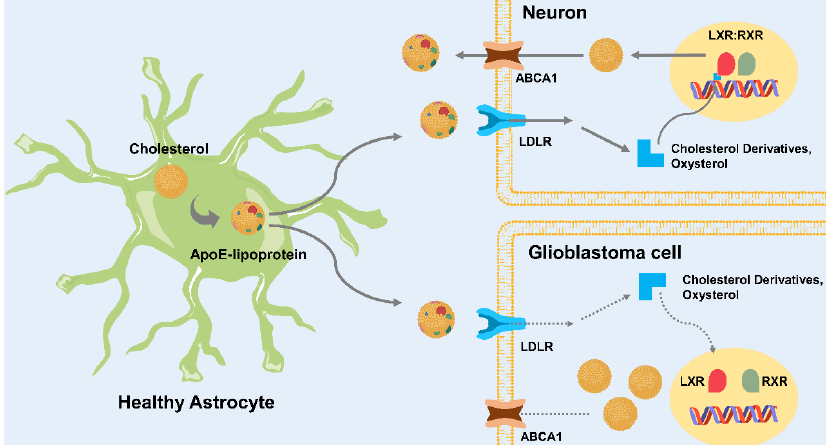
Figure 1. Neuron and GBM cells depend on astrocytes to synthesize cholesterol via de novo synthesis. Neurons and GBM cells do not use de novo synthesis of cholesterol. Instead, they uptake exogenous cholesterol in ApoE-lipoprotein from astrocytes. ApoE-lipoprotein interacts with LDL receptors. Then, oxysterol and cholesterol derivatives, which are physiological agonists for LXR, are produced in neurons. The activation of LXR results in its dimerization with RXR (LXR:RXR). Following the formation of LXR:RXR heterodimerization, ABCA1, an exporter of cholesterol as ApoE-lipoprotein, is increased. LXR:RXR decreases LDL receptor. Both the regulation of ABCA1 and LDL receptor can regulate the level of cellular cholesterol. In GBM cells, this cholesterol regulation is disrupted. Oxysterol and cholesterol derivatives are unable to activate LXR. Thus, the accumulation of cellular cholesterol in GBM. ABCA1, ATP-binding cassette transporter A1; ApoE, apolipoprotein E; LDLR, low-density lipoprotein receptor; LXR, liver X receptors; RXR, retinoid X